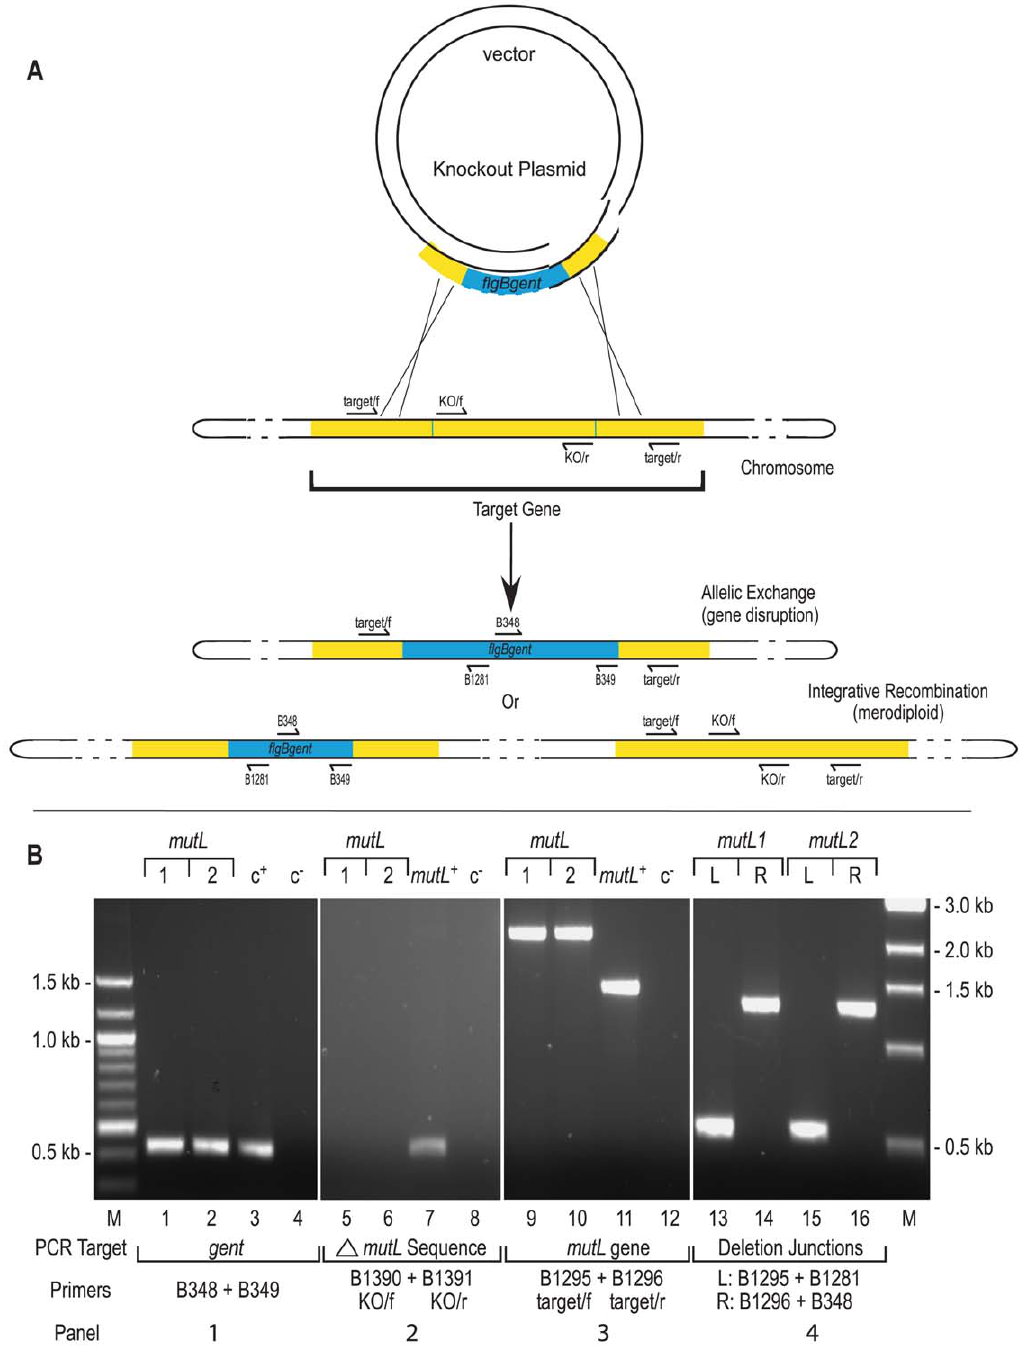
Figure 1. Gene disruption and confirmation. A) Gene disruption strategy. The infectious B. burgdorferi strain B31, clone 5A4 (B31-5A4) was transformed with a knockout plasmid carrying a one kb gentamicin cassette (blue) that replaced the central portion of the target gene (yellow) as described in Materials and Methods. The two possible outcomes of recombination events with the target gene are shown: allelic exchange would result in gene disruption while integrative recombination of the knockout plasmid would resultin merodiploid formation. The position of PCRprimers used for construct verification are shown by arrows on the schematic. B) Construct verification of the mutL disruption by PCR. Each gene disruption was subjected to four PCR analyses. 1) The presence of the gentamicin resistance cassette was confirmed as shown in lanes 1 and 2. The shuttle vector pBSV2G [71] served as the positive control c + for amplification of the gent cassette (lane 3.) 2) The portion of mutL expected to be deleted in a gene disruptionwas not detected ineither mutL 1 or2 (lanes 5 and6); however, it was detectedin thepositivecontrol(c + ), whichcontained wild-type B31-5A4 DNA as a template in lane 7. 3) The size of the target gene was compared in mutL 1 and 2 genotypes. The expected 2.1 kb products for a gene disruption were observed (lanes 9 and 10) in comparison to the 1.5 kb product from the mutL + genotype (lane 11). Lanes 4, 8 and 12 are negative controls (c 2 ) that lacked DNA template. 4) Confirmation of the correct insertion site was performed using combinations of the target gene primers and primers internal to thegentamicin cassette to amplify the boundaries. Theleft boundary inboth mutL clones gavetheexpected0.55 kb product (lanes 13 and15). Theright boundary in both clones gave the expected product of approximately 1.3 kb (lanes 14 and 16). A 100bp ladder on the left side, relevant to the two left panels, and a 1kb ladder on the right side, which applies to the two right panels, were the molecular weight markers (M)